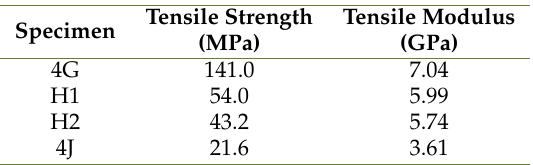
Fig. 9. Comparison of load-deflection plots of glass/jute hybrid